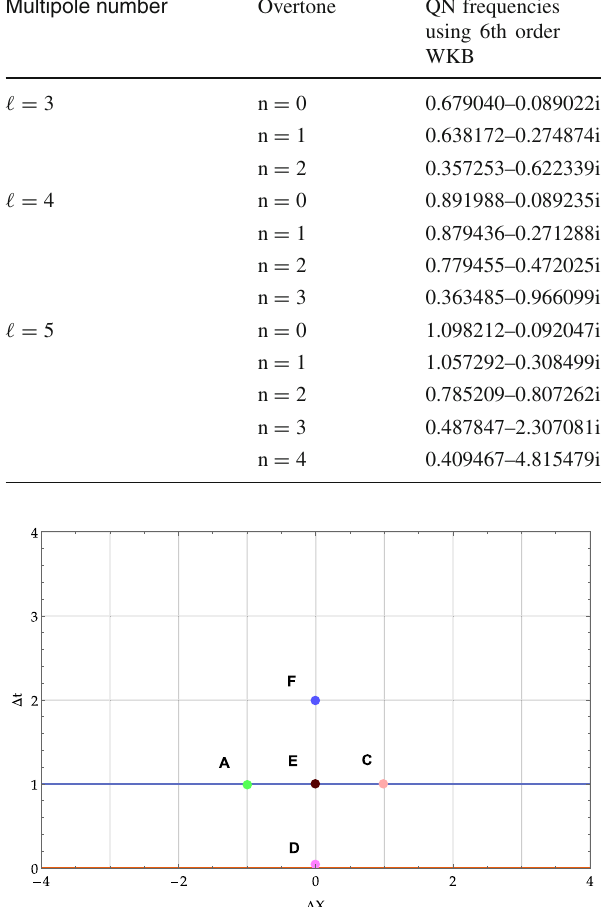
Table 2 The list of gravitational QNMs in the Bardeen de-Sitter black hole space time as a function of (cid:12) and n for q = 0 . 60 and (cid:2) = 0 . 003 Multipole number